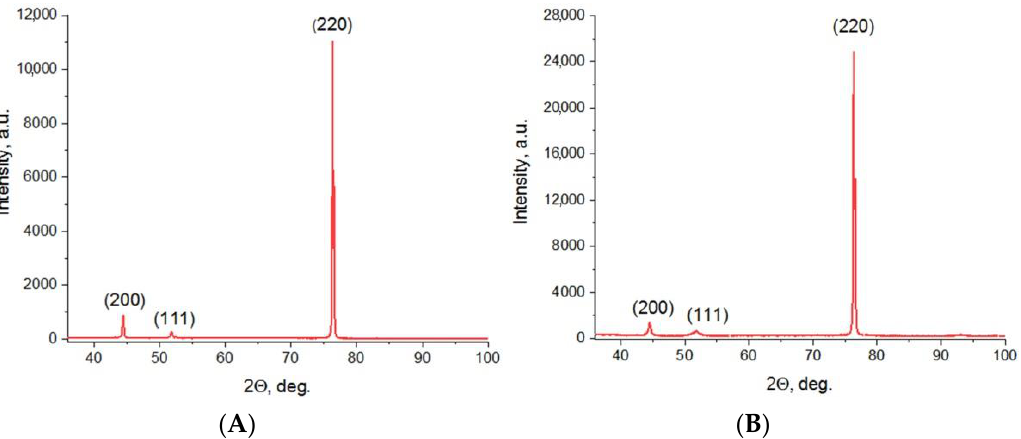
Figure 5. The XRD spectra for the Ni NWs in MPAA: ( A )—I type (Sample 3); ( B )—II type (Sample 4).